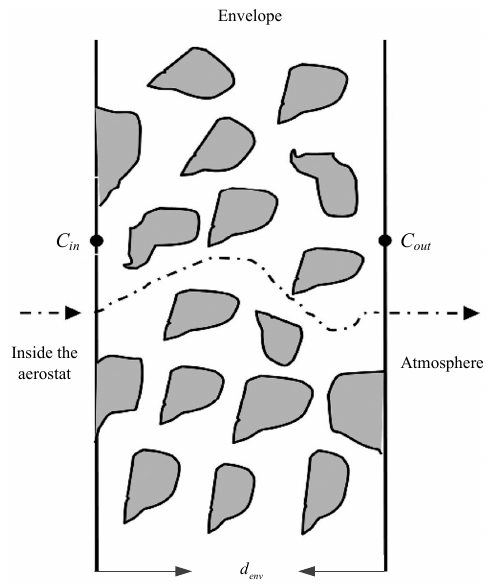
Figure 3. The mass transfer mechanism of lifting gas passing through an envelope [23].